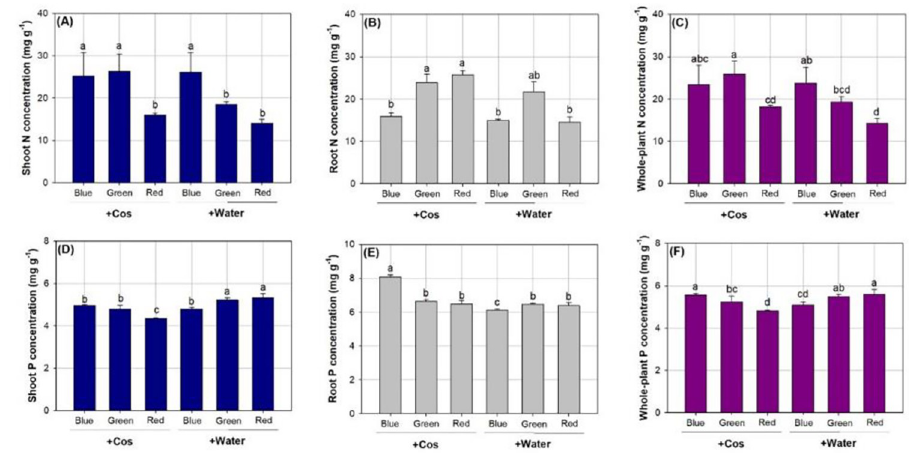
Fig 5. Concentrations of nitrogen (N) (A, B, and C) and phosphorus (P) (D, E, and F) in parts of shoot (left), root (middle), and whole plant (right) in Podocarpus macrophyllus seedlings exposed to chitosan (+Cos) or water (+Water) sprays in three types of light-emitting diodes spectra from red, green, and blue lights. Bar height corresponds to the mean of the measurement while the error bars represent standard errors. Different letters represent difference at significant level of 0.05 by Tukey